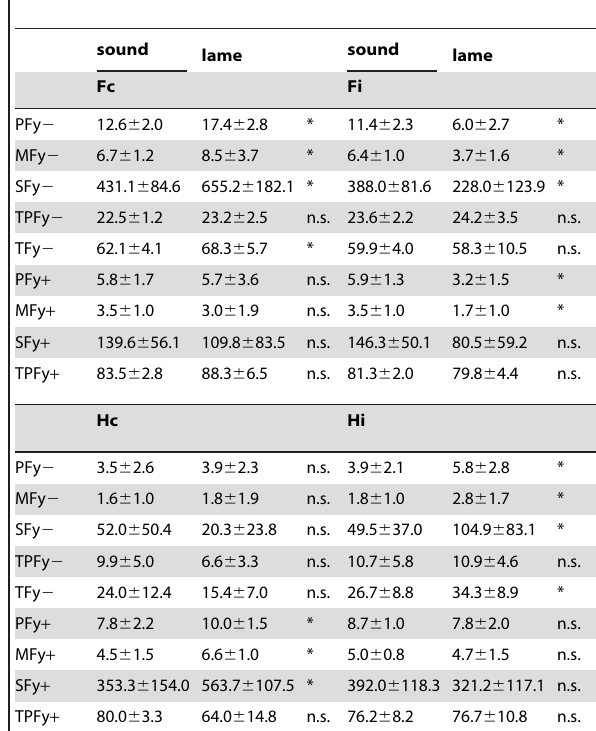
Table 2. Mean (M) and peak (P) as well as the sum (S) of the braking (Fy 2 ) and propulsive (Fy + ) forces in %BW for the sound condition and when lameness was induced in the right forelimb (Fi) in the trotting